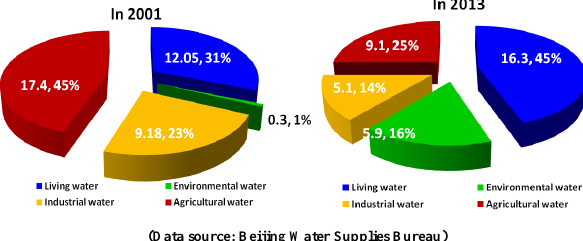
Figure 4. Contrast analysis diagram of water consumption structure in 2001 and 2013 in Beijing.